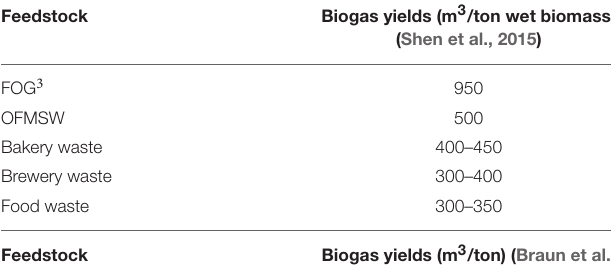
TABLE 4 | Biogas yields for the most common co-digestion feedstock.